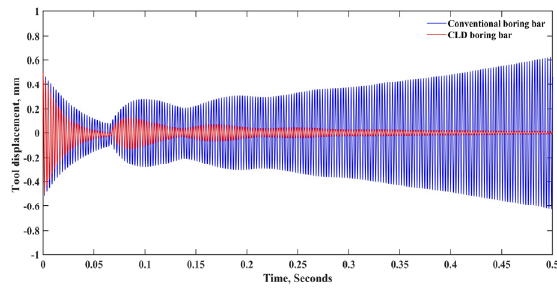
Figure 9. Tool-tip displacements of the conventional and CLD boring bar at a speed of 900 rpm and 0.05 mm depth of cut